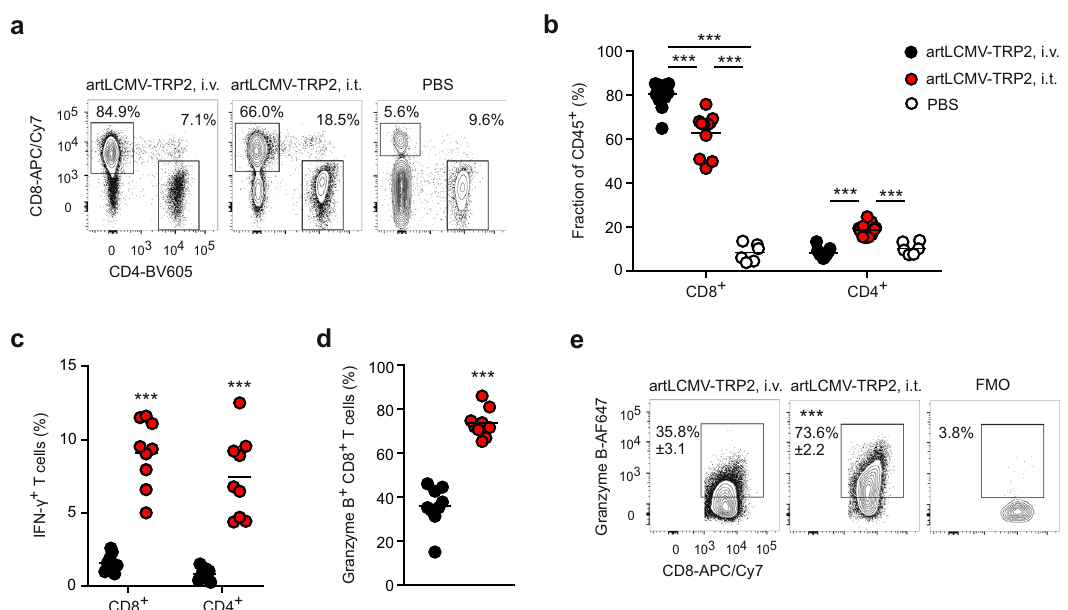
Fig. 2 T cell activity after intratumoral artLCMV-TRP2 treatment. a – d B16F10-tumor bearing mice were treated on day 7 with artLCMV-TRP2 i.v. or i.t. Flow cytometric analysis of tumor-in fi ltrating T cells on day 15: Representative plots ( a ) and quanti fi cation of CD8 + and CD4 + T cell frequency ( b ). c IFN- γ -producing CD8 + and CD4 + T cells. Granzyme B-expressing CD8 + T cells ( d ) with representative plots ( e ). Dots represent individual mice and lines indicate mean values. Pooled data from two independent experiments with n = 6 (PBS), n = 13 (artLCMV-TRP2, i.v.) and n = 11 (artLCMV-TRP2, i.t.) mice ( b ); n = 9 (artLCMV-TRP2, i.v. and i.t.) mice ( c , d ). Statistical analysis was performed using one-way ANOVA with Tukey ’ s multiple comparison test ( b ) or unpaired two-tailed Student ’ s t test ( c , d ) with * P < 0.05: ** P < 0.01; *** P < 0.001. Source data and exact P values are provided in the Source data fi